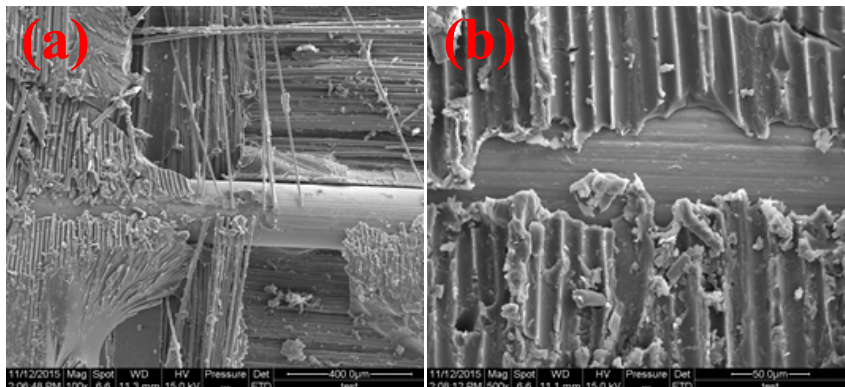
Figure 8. SEM micrographs of SMA in the composites after low-velocity impact damage: ( a ) magnification of 100, and ( b ) magnification of 500.